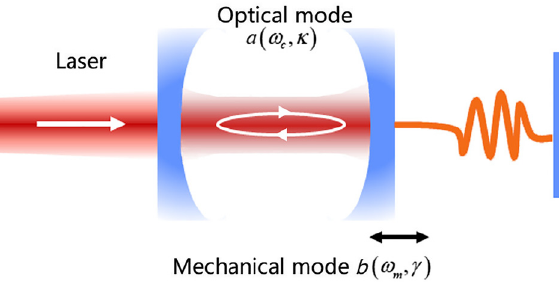
Figure 1: Schematic of a typical optomechanical system, with a laser-driven Fabry–Perot (F–P) cavity. The left mirror is fixed and the right mirror is